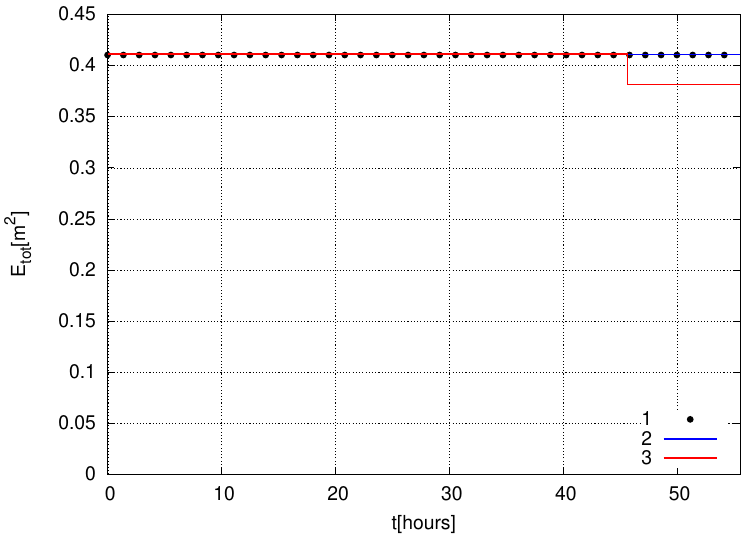
Figure 3. Dependence of the total energy E tot on simulation time for numerical experiments with µ = 0.04 and ˜ k p = 10 in different models. The black dots 1 corresponds to the NLS model, the blue solid line 2—to the SCZ equation and the red solid line 3 to the RV